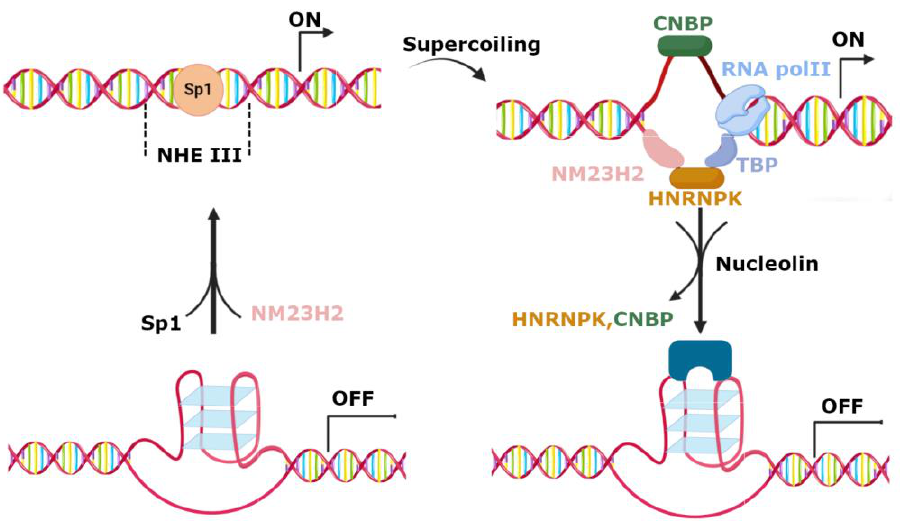
Figure 3. Schematic representation of c-MYC transcription regulation. G4 can downregulate the transcription by preventing the recognition of transcription factors. NM23H2 can unfold G4 leading to the transcriptional active DNA form. Single-strand DNA formation is induced by negative supercoiling, allowing for the binding of heterogeneous nuclear ribonucleoprotein K (HNRNPK) and the cellular nucleic acid binding protein (CNBP), and the posterior activation of c-MYC transcription. A negative regulation of this transcription occurs via the stabilization of G4 with nucleolin. Adapted from [24].